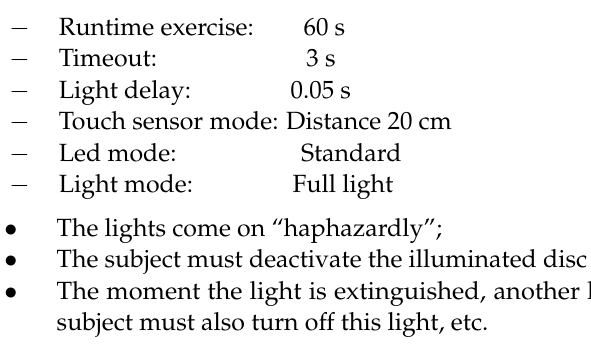
Figure A1. FitLight ® s for testing Reaction Time. The specification of this experimental set-up. Hand/eye coordination set